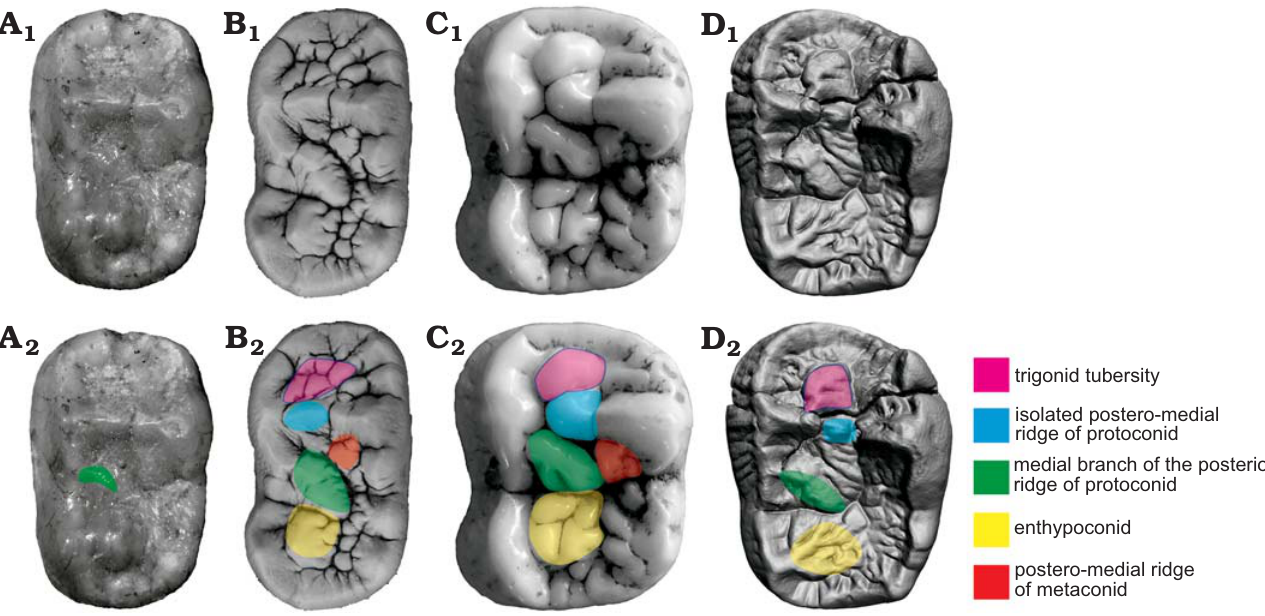
Fig. 11. Occlusal views of m2 homologous structures in cave bear (A, B) and giant panda (C, D) lineages. A . Ursavus tedfordi Qiu, Deng, and Wang, 2014 (HMV1453) from Huaigou, Gansu Province, Late Miocene. B . Ursus deningeri von Reichenau, 1904 (NMM1956/909, photo Jan Wagner) from Mosbach 2, Germany, early Middle Pleistocene. C . Ailuropoda wulingshanensis Wang and Lin, 1982 (IVPP V13459.91) from Longgu Cave, Jianshi, Hubei Province. D . Ailurarctos lufengensis Qiu and Qi, 1989 (IVPP V6892) from Lufeng, Yunnan Province, Latest Miocene. A 1 –D 1 , photographs; A 2 –D 2 , photographs with homologous structures indicated. Not to